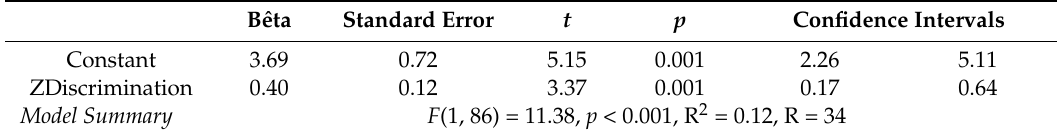
Table 2. Direct effect of discrimination on identification.